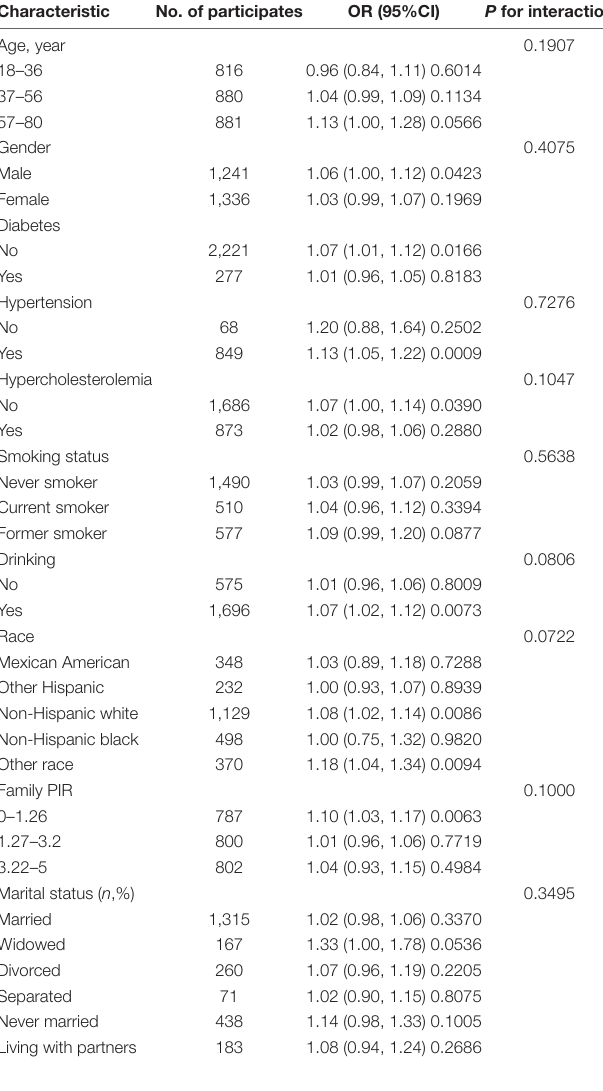
TABLE 4 | Results of subgroup analysis and interaction